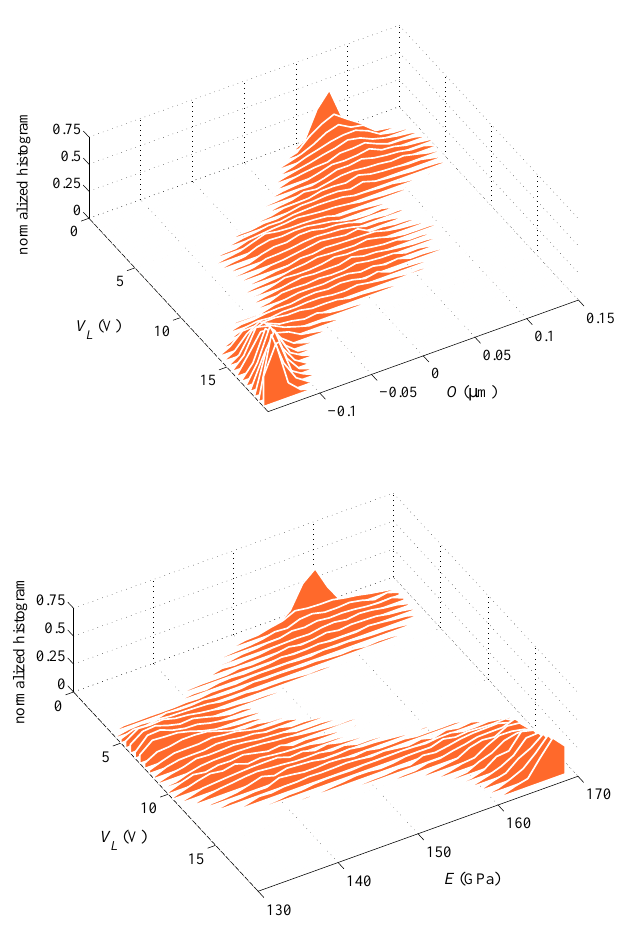
Figure 11. Specimen #5, lateral actuation case, ξ O = ξ E = 0.75: evolution of the PDFs of ( a ) O and ( b ) E corresponding to the evolution of estimates represented by orange curves in Figure